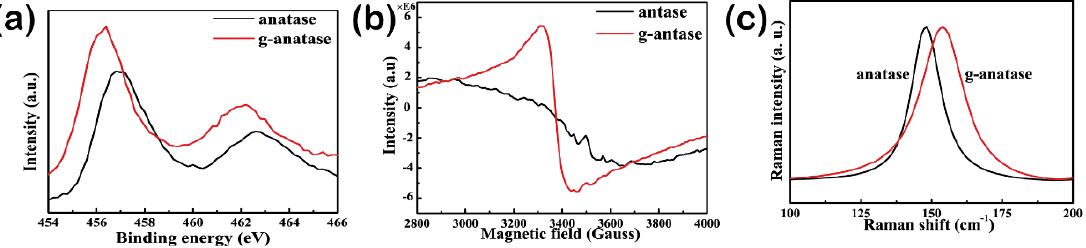
Figure 5. ( a ) High-resolution XPS spectra of Ti 2p, ( b ) electron paramagnetic resonance (EPR) and ( c ) Raman spectra of anatase and colored anatase.